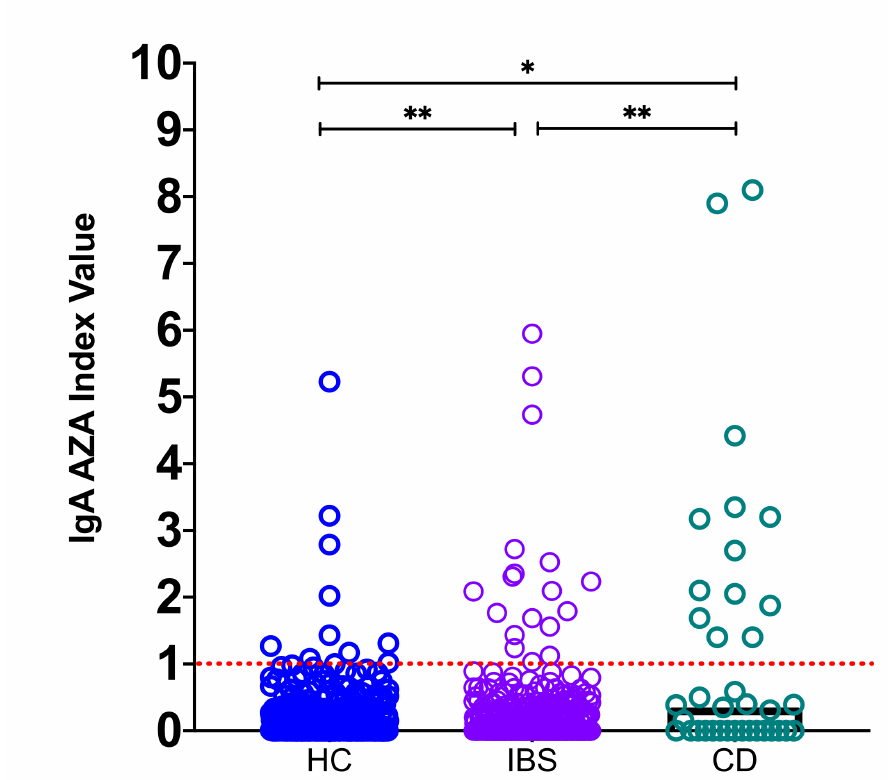
Figure 1. High serum levels of IgA anti-zein antibodies (AZA) in celiac disease (CD) patients. Cut-off values were calculated and determined as described in the Materials and Methods, and they are shown by dotted lines. Medians values are compared between the groups. * p <0.05, ** p